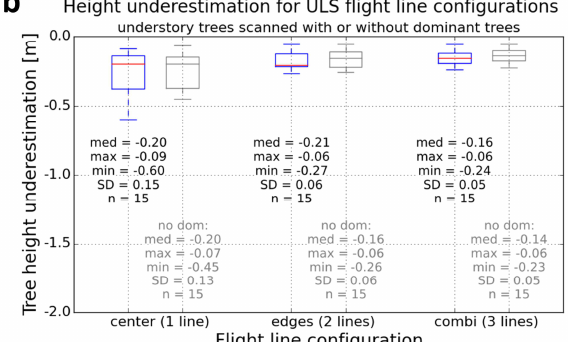
Figure 6: Differences between uCHMs derived from the reference point cloud, and from synthetic point